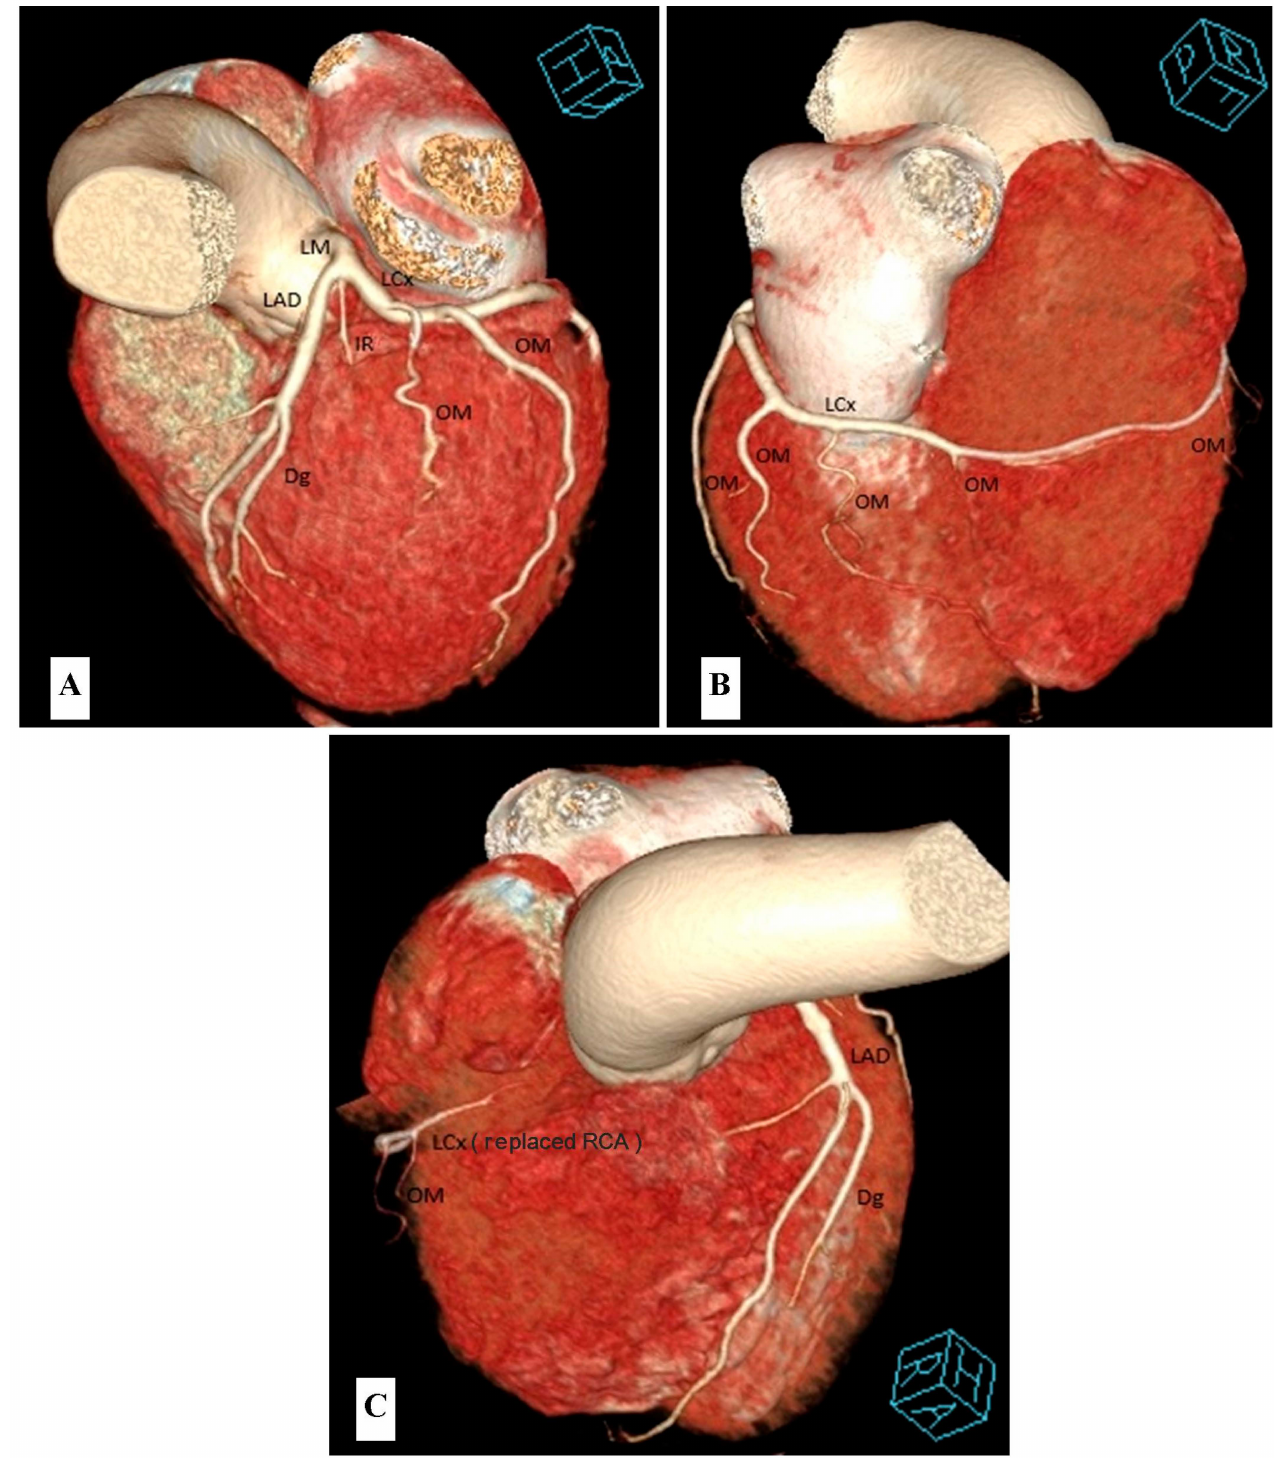
Figure 2. Cardiac computed tomography angiography. Angiographic phase. Volume